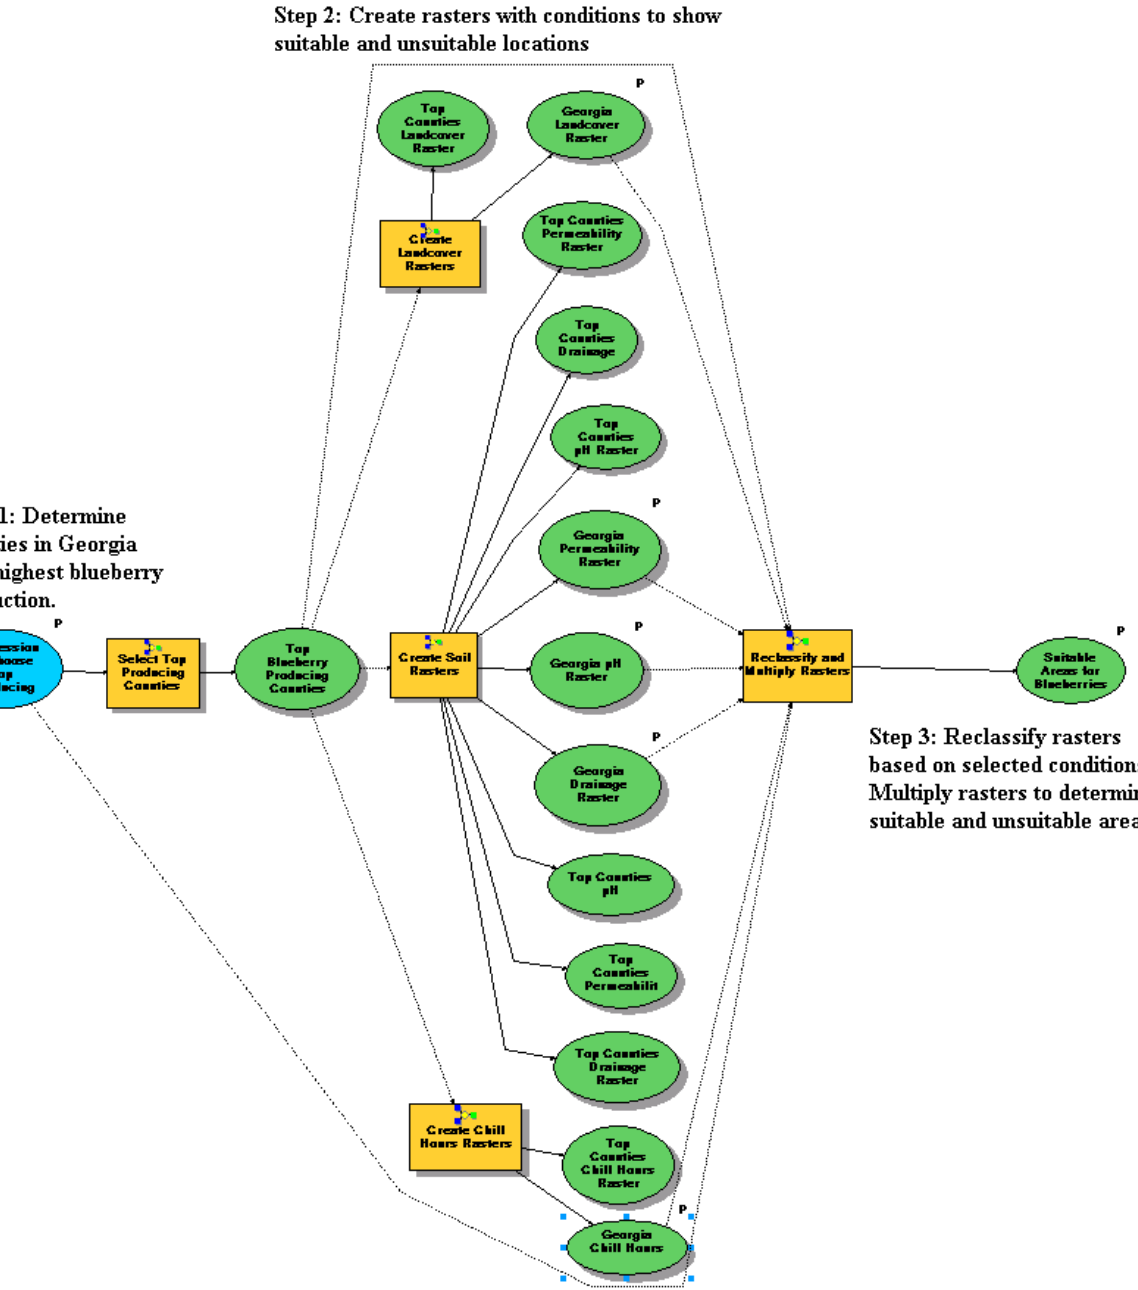
Figure 6. Geospatial model developed in ArcGIS Model Builder for the blueberry crop suitability analysis in the State of Georgia,